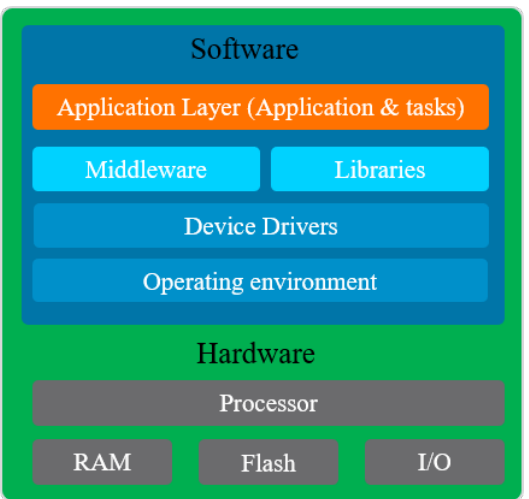
Figure 5. Layers of the EBCI based on software